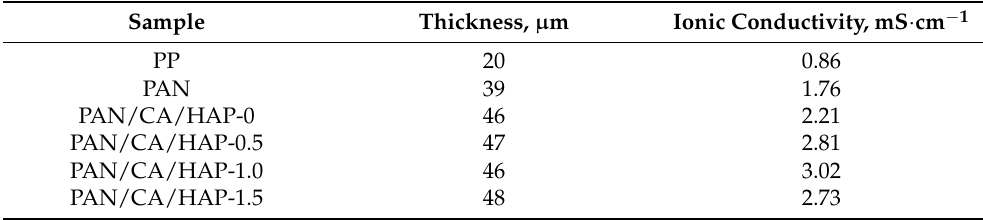
Table 1. The thickness and ionic conductivity of different separators.